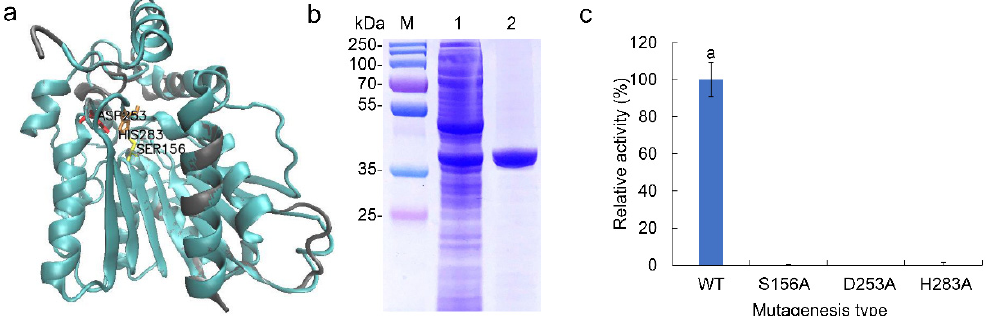
Figure 2. Tree dimensional structure, purification and enzyme activity of the mutants of EstDR4. ( a ) The predicted three- dimensional structural model of EstDR4. The tertiary structure of EstDR4 (blue ribbon) was modeled on that of Est8 (PDB 4YPV, gray ribbon). Potential catalytic triad residues (Ser156, Asp253 and His283) are marked on the figure. ( b ) SDS-PAGE electrophoresis of EstDR4. Lane M: marker, lane 1: crude, lane 2: purified EstDR4. The EstDR4 protein band at ~35 kDa, was in accordance with the prediction that EstDR4 (33 kDa) added with the HisTag. ( c ) WT is the wild type EstDR4, the mutants are S156A, D253A and H283A. The different letters between each condition indicate significant differences ( p < 0.05).